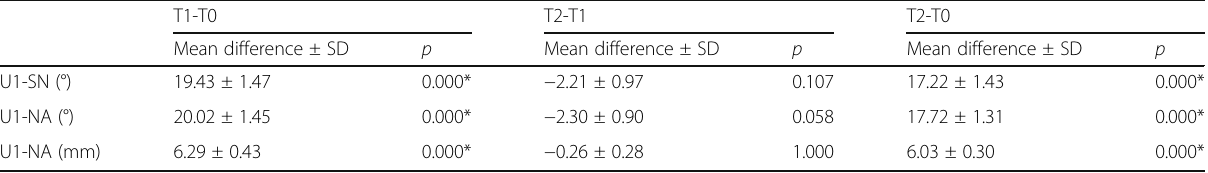
Table 2 Cephalometric measurement changes of the study group in different treatment